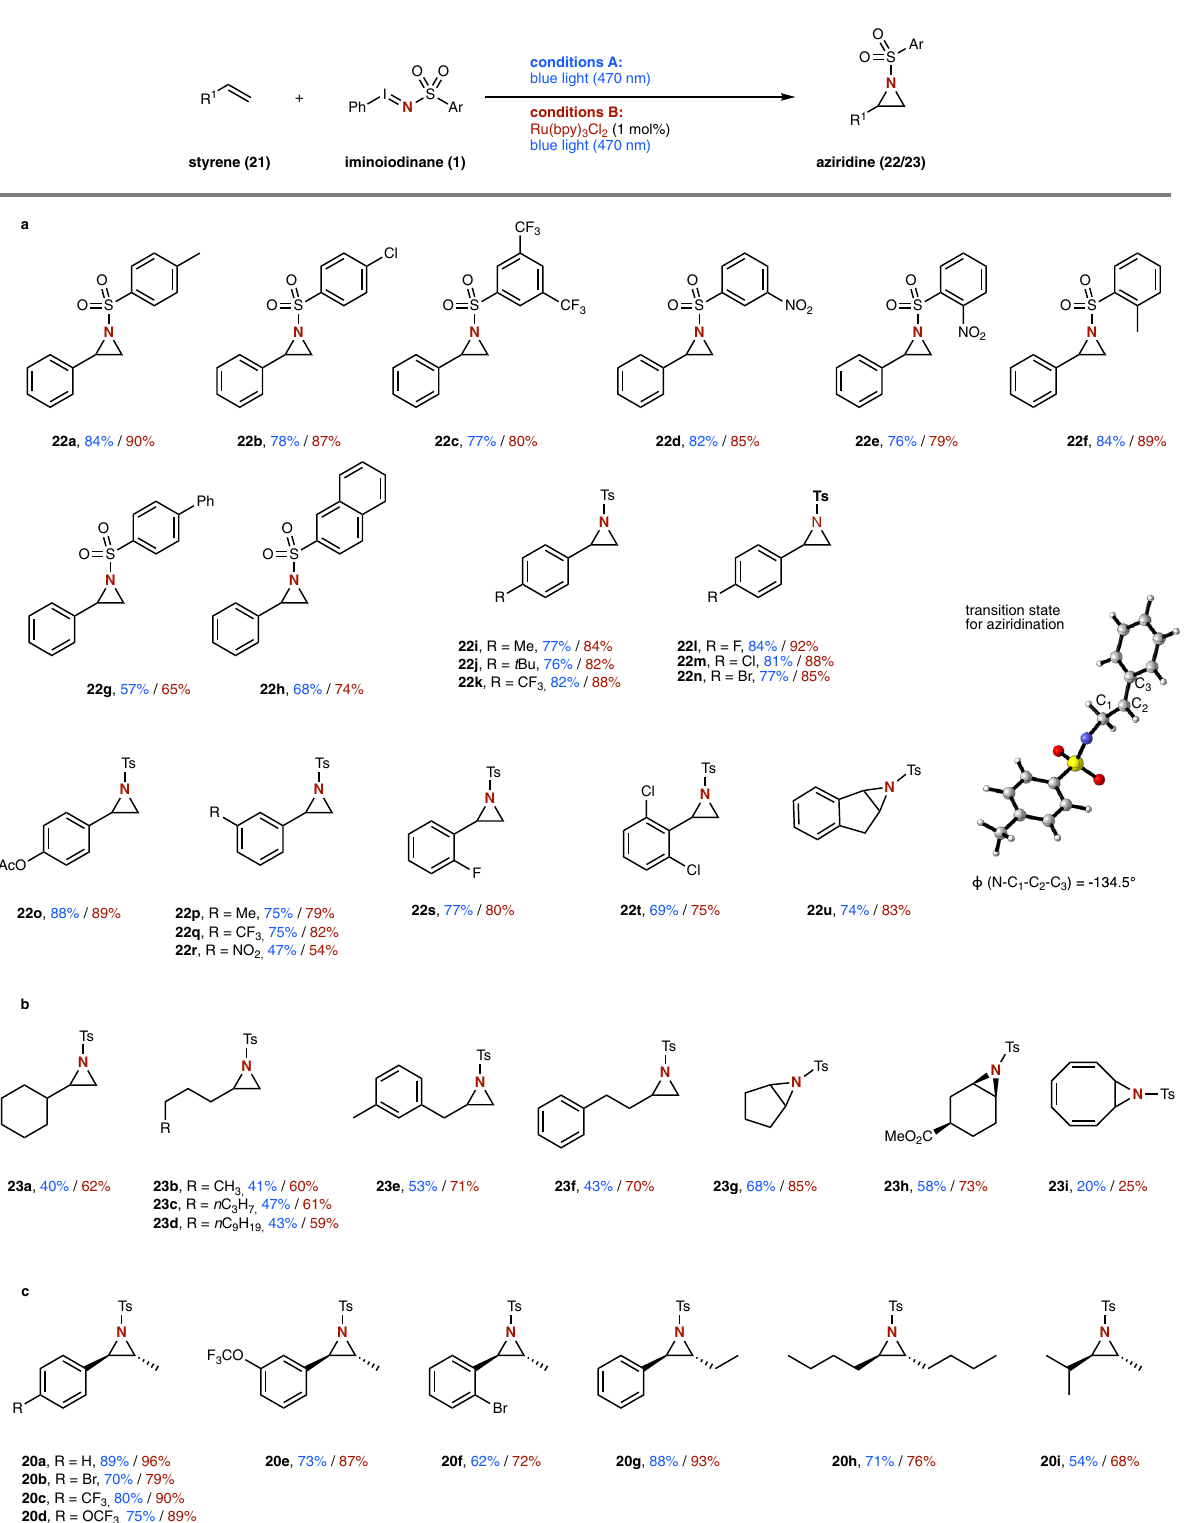
Fig. 6 Scope of the photochemical and photocatalytic nitrene transfer reactions with styrenes and aliphatic ole fi ns. a Evaluation of styrene derivatives. b Evaluation of aliphatic ole fi ns c evaluation of 1,2-disubstituted ole fi ns. imaginary frequency). Key transition-state structures were con fi rmed to connect theory in combination with D3 dispersion corrections 34 , in which all atoms were corresponding reactants and products by intrinsic reaction coordinate (IRC) described with the def2-SVP basis set 35 . Analytical frequency calculations were calculations 36,37 . The electronic energy was then re fi ned using def2-TZVP basis carried out at the same level of theory in order to con fi rm each stationary point as either an intermediate (no imaginary frequencies) or a transition state (only one set 35 at the (U)M06-2X level on the optimized geometries in combination with D3